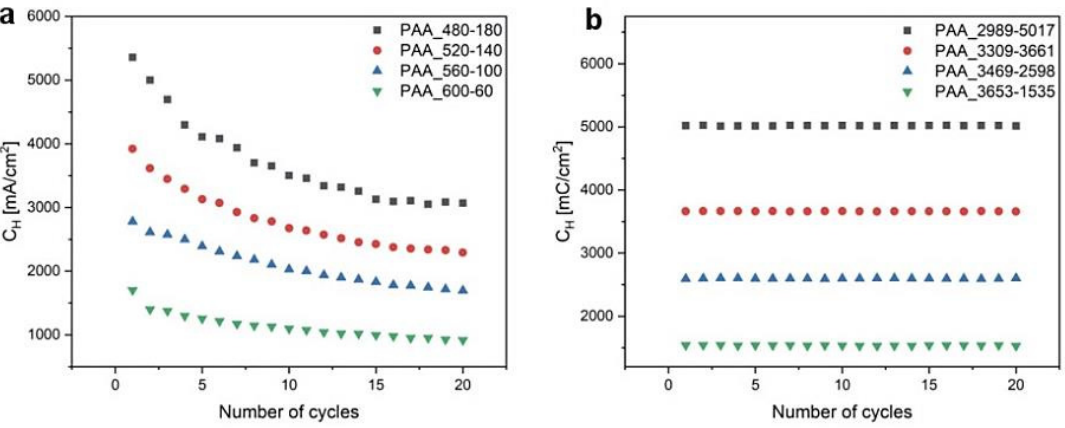
Figure 6. C H as a function of the number of cycles determined for ( a ) time- and ( b ) charge density-controlled mode pulse anodization.